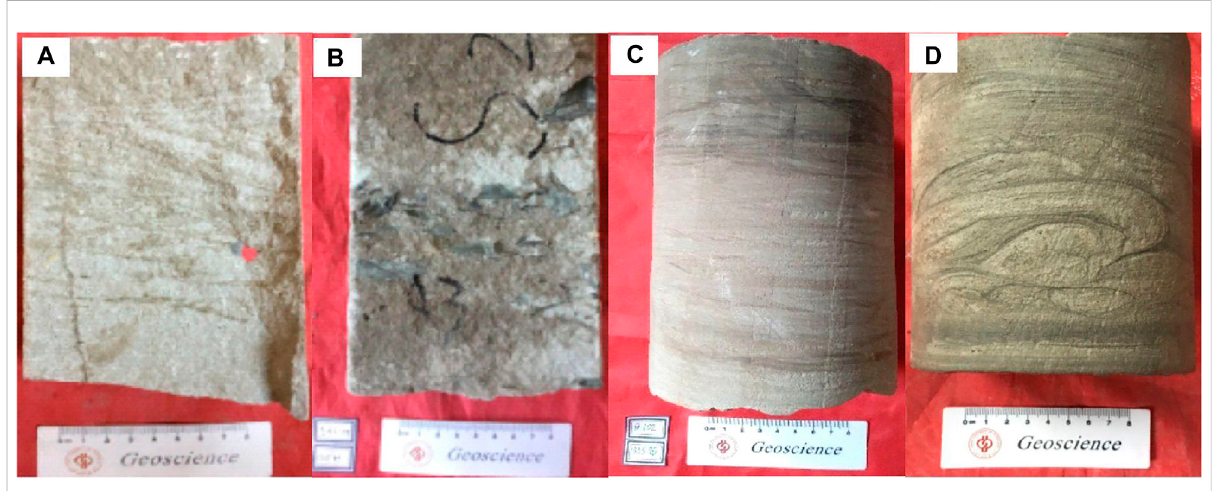
FIGURE 2 Core characteristics of the Quan 3 Member in the Fuxin Uplift. Notes: (A) Point bar, fi ne sandstone with wedge cross bedding, Well J+28 – 015.1,1272.62m; (B) Distributary channel, fi ne sandstone with argillaceous gravel, Well J+2 – 014, 1373.97m; (C) Distributary channel, silt-